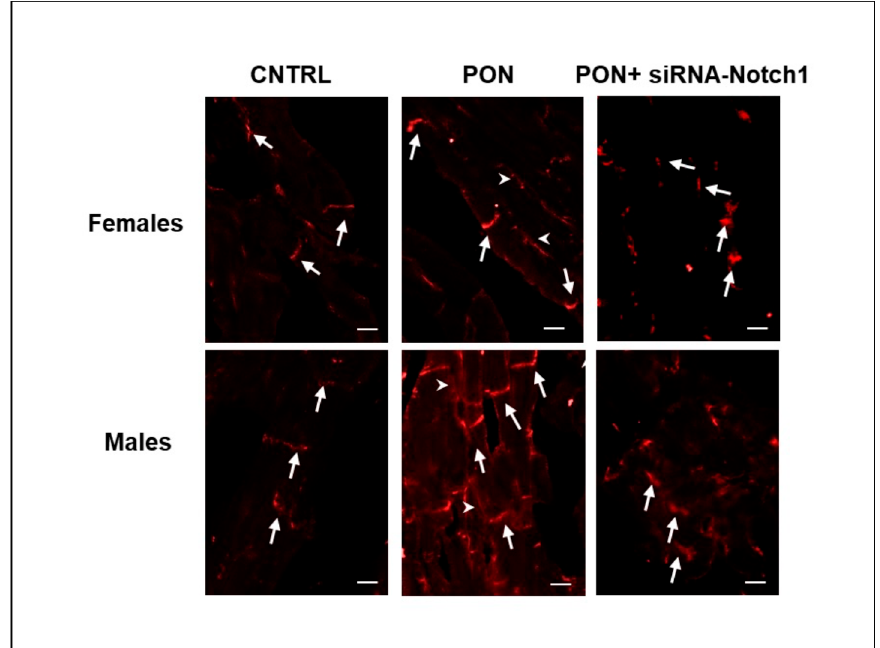
Figure 6. PKCps immunofluorescence staining in cardiomyocytes. Representative images of PKCps immunopositivity (red) at intercalated discs (arrows) and at lateral borders (arrowheads). Magnification: 200×. Bars: 10 µm.